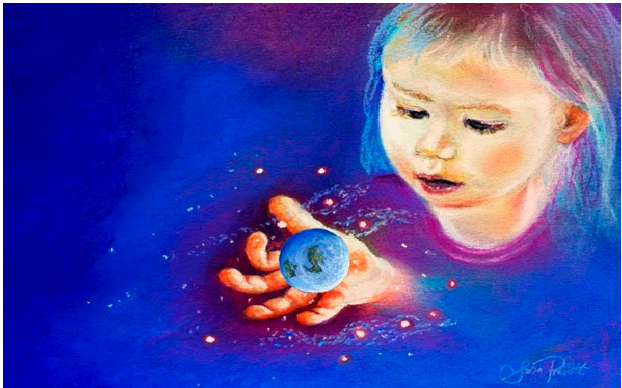
Figure 2. Planetary health depends on inspiration and imagination. Solutions will depend on the engagement that comes from unity and purpose, and the sense of awe and wonder inspired by nature. Artwork by SLP.